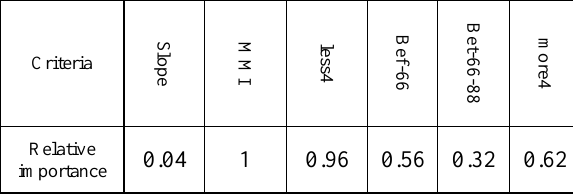
Table 4. Relative importance of the criteria, normalized with respect to the most important criterion